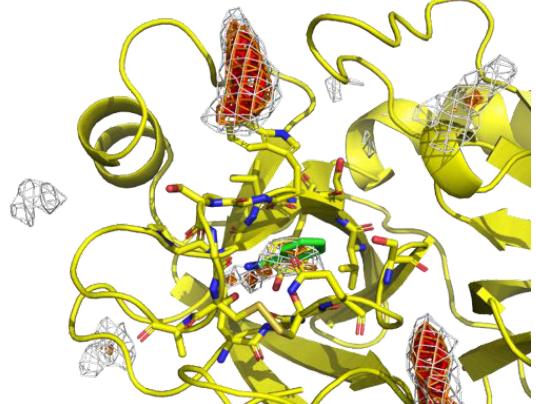
Figure 2. An example of preferable protein surfaces based-on max-PMAP. Positions shown as meshes are preferable protein surfaces, where the value of max-PMAP is higher than a threshold. The gray, orange, and red meshes show the same max-PMAP but different thresholds.